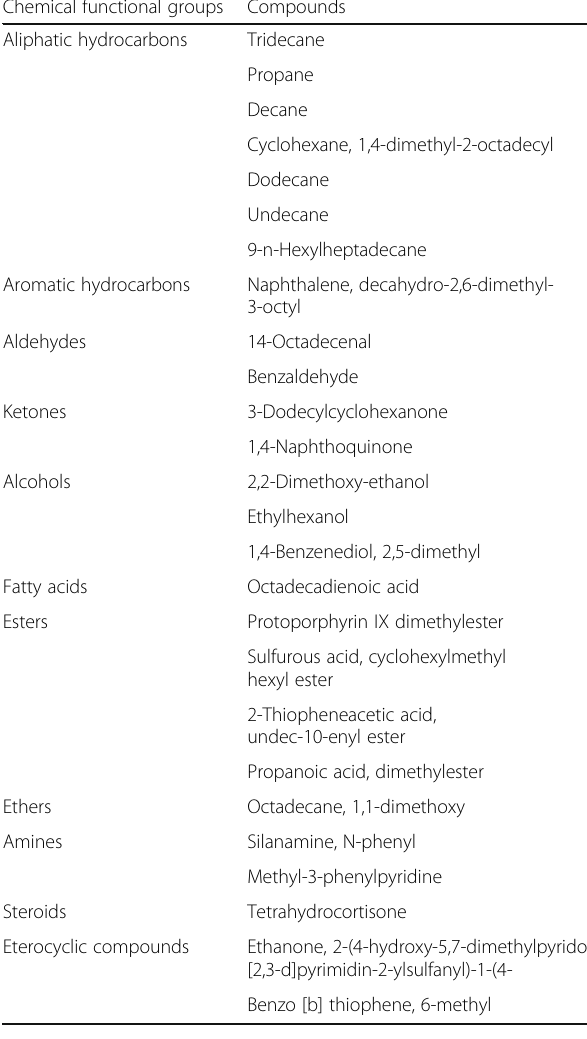
Table 3 VOCs related to the composition of human secretions Chemical functional groups Compounds